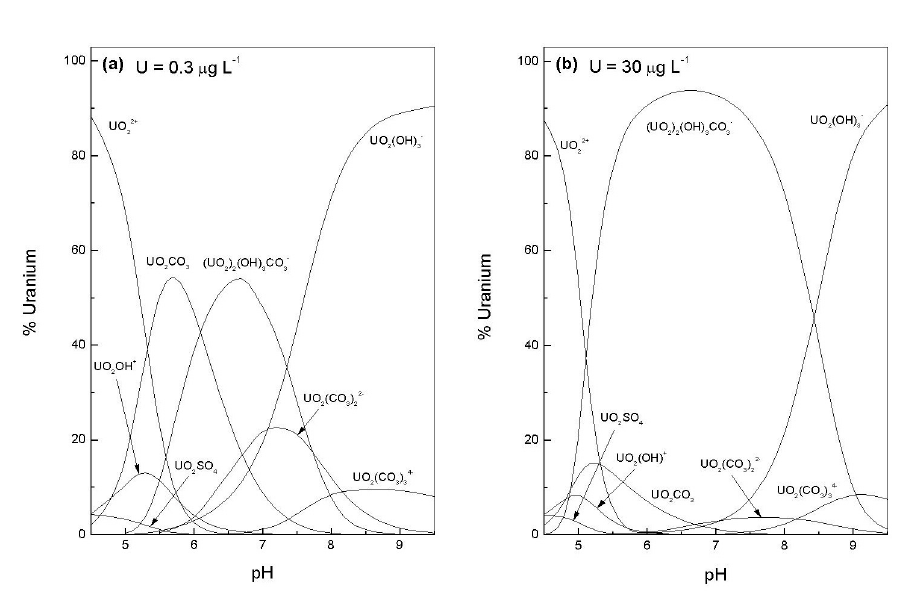
FIGURE 1. Predicted speciation (% distribution) of U as a function of pH (4.5 to 9.5) for a model freshwater at (a) 0.3 (cid:181)g U l -1 and (b) 30 (cid:181)g U l -1 without humic substances. U species <2% are excluded for clarity. U speciation was calculated using HARPHRQ and based on the ionic composition of the Hawkesbury-Nepean River, Sydney, Australia[118] (carbonate = 40 mg l -1 ; sulfate = 9.4 mg l -1 ; chloride = 5.1 mg l -1 ; ionic strength = 0.002 M). Stability constants for U at 25 ° C were taken from Markich and